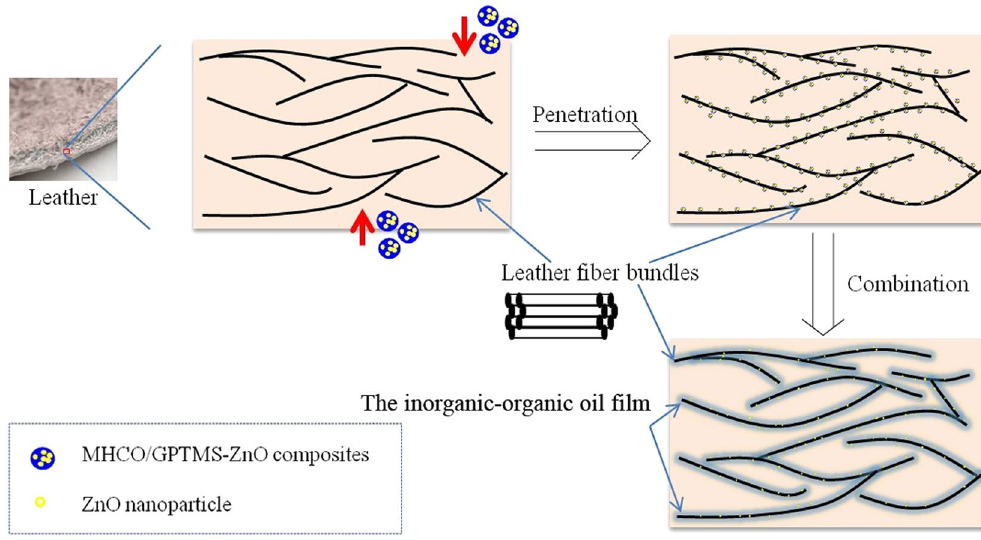
Figure 12. Schematic illustration of UV resistance of leather treated with MHCO/GPTMS-ZnO